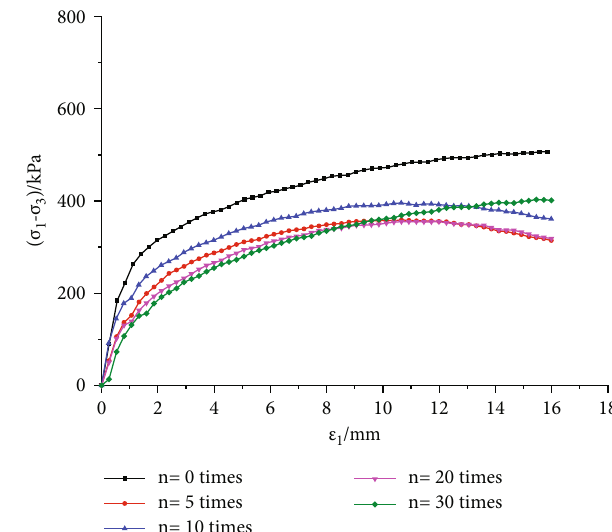
Figure 5: Stress-strain curves under di ff erent freeze-thaw cycles (-10 ° C).